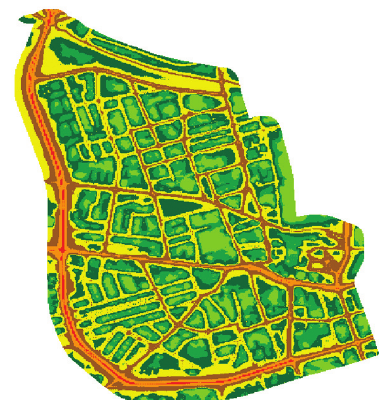
Fig. 7. Modelled noise level of segment 1 of the central part of Panevėžys city in the day-time